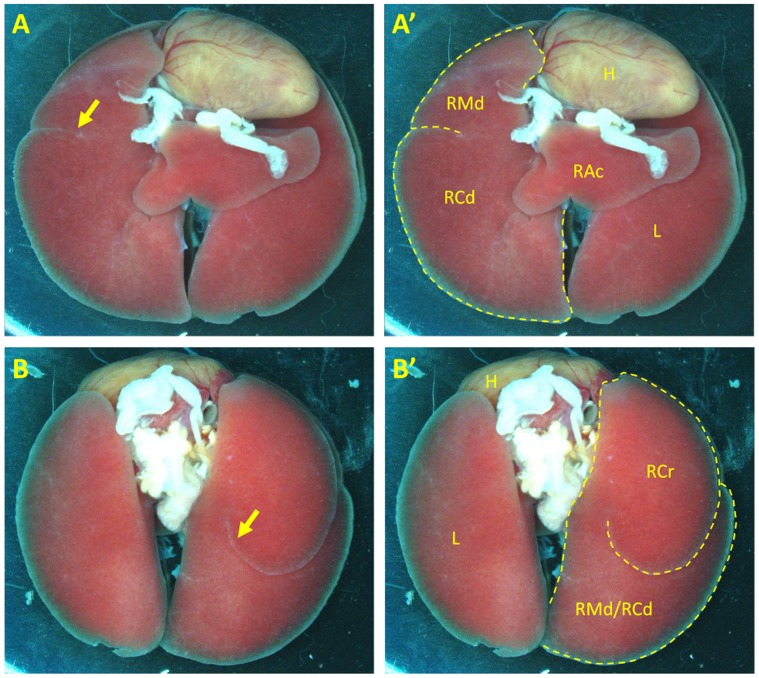
FREM1 deficiency causes lung lobulation defects in mice.(A and A′) Ventral view of the lungs of a Frem1
eyes2/eyes2 mouse in which the right middle (RMd) and right caudal lobe (RCd) are fused with only small, partial fissures defining the boundaries of each lobe (yellow arrow). (B and B′) Dorsal view of the same lungs showing partial fusion of the right cranial lobe (RCr) to the fused right middle and caudal lobes (RMd/RCd) with an incomplete fissure separating these lobes (yellow arrow). In A′ and B′, the right lung lobes are outlined with a dashed yellow line. The left lung (L) and the right accessory lobe (RAc) are normal. H = heart.